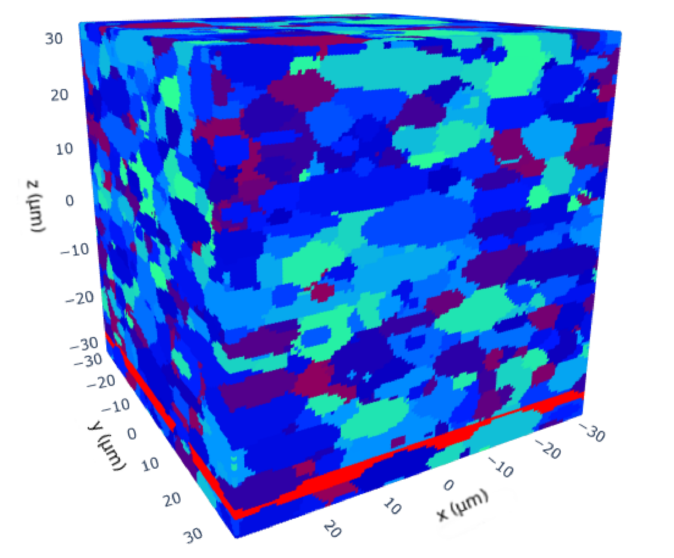
Figure 9. RVE with a martensite band shown in red color. The martensite band is defined as a volume within the cube that must contain at least 60% of